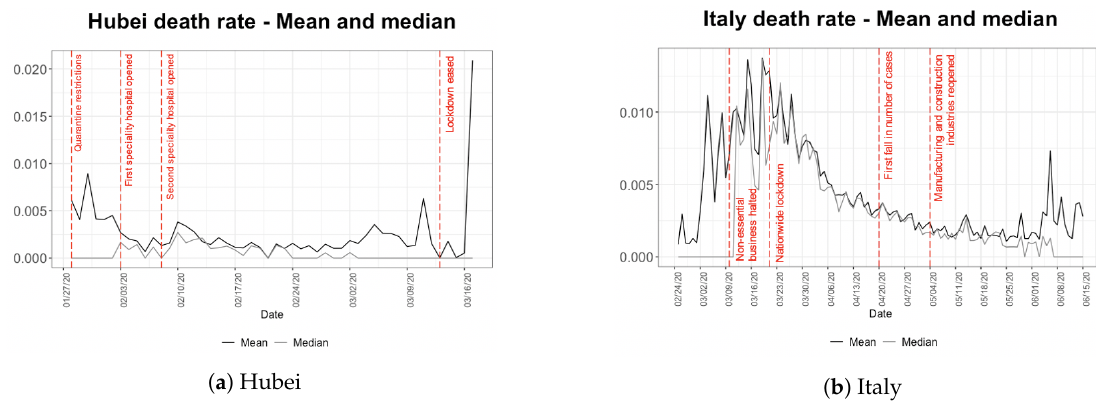
Figure 8. Time series plots for mean and median death